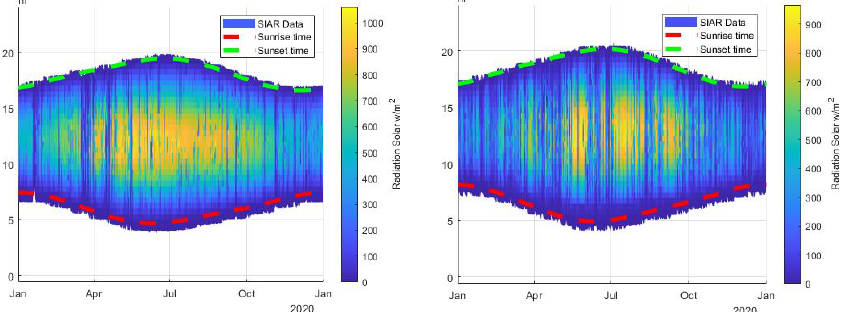
Figure 6. Visual validation for V29 and C01. X-axis is the day; Y-axis is the time in Universal Time Coordinated (UTC). The color of the surface, from blue (0 W.m −2 ) to yellow (1000 W.m −2 ), is the value of the data.